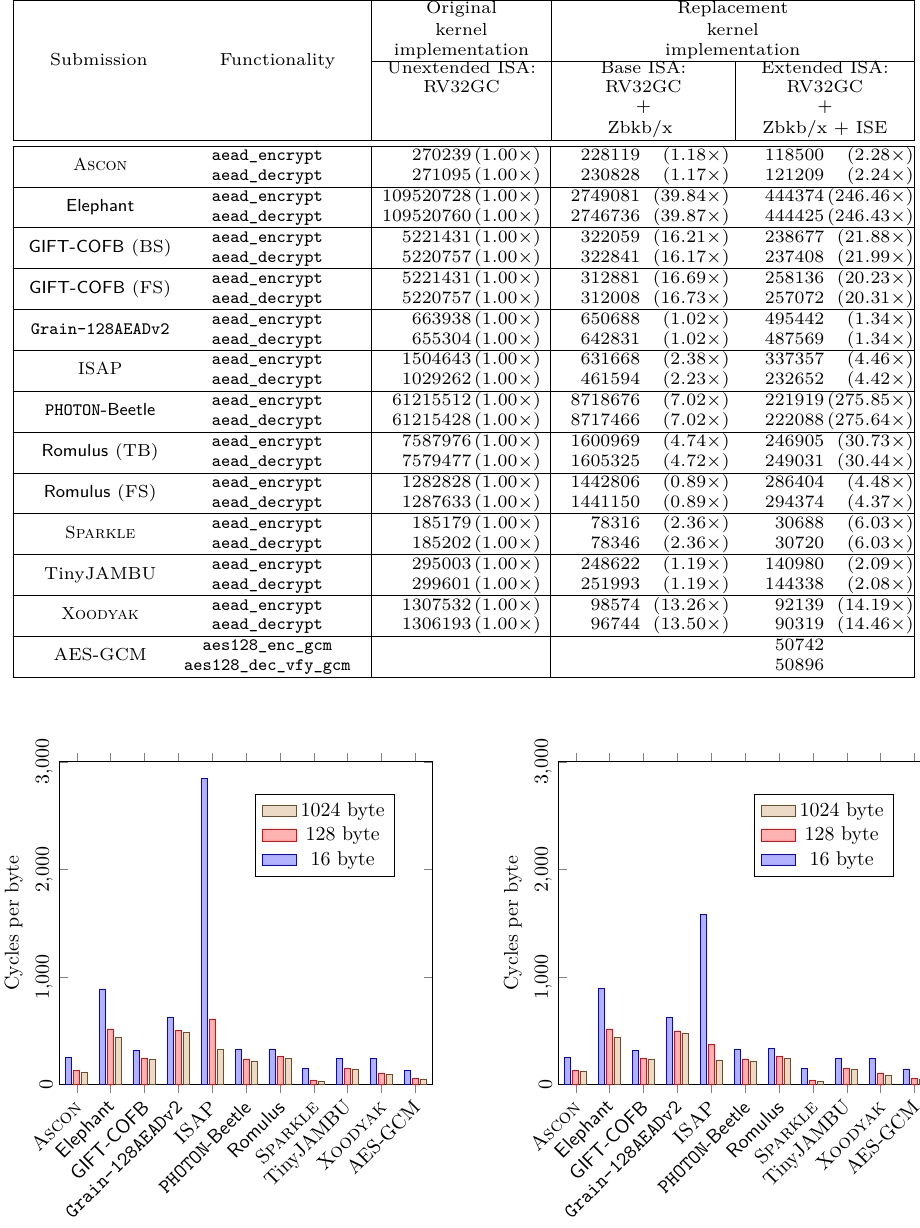
Table 6: Software-oriented evaluation, i.e., utilisation of each ISE design: latency measured in clock cycles (plus increase/decrease factor versus unextended ISA in parentheses) for indirect kernel use via AEAD API (with 1024 B plaintext, ciphertext, and associated data).